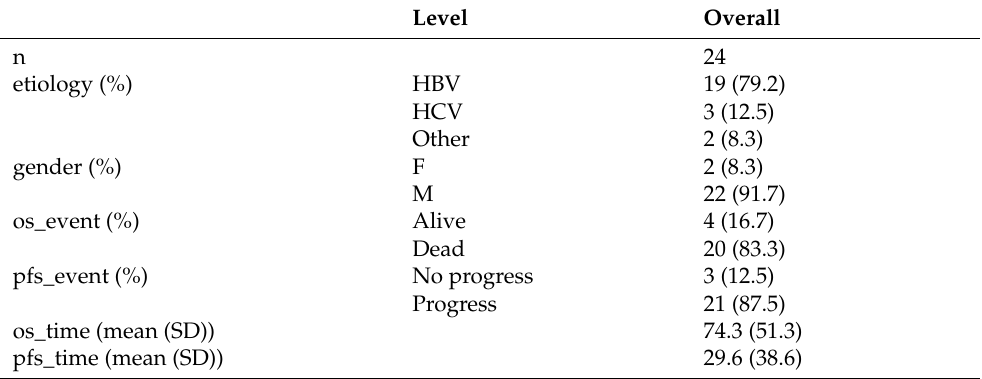
Table 1. Patients overall back ground for GSE140901.